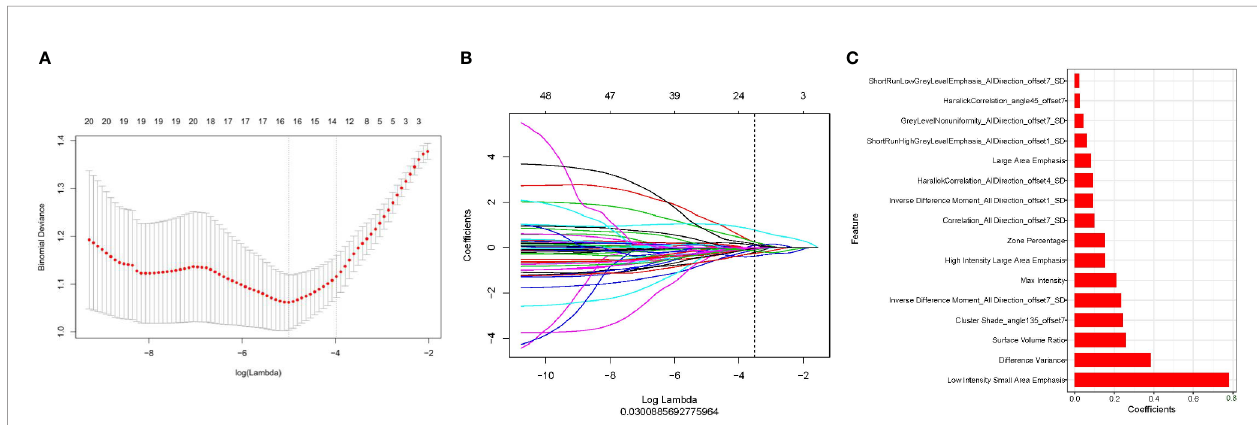
FIGURE 3 | Use of lasso logistic regression to select features. (A) Binomial deviation versus parameter l . Least absolute shrinkage and selection operator (LASSO) regression was used to screen the radiomic features, and cross-validation was used to select the optimal model parameter l . The vertical axis is the binomial deviation, and the horizontal axis is the log ( l ) value. l , which represents the smallest binomial deviation of the model, is the optimal value (vertical dashed line). (B) Graph of the variation of the imaging omics feature coef fi cient with l . The number above indicates the number of fi ltered features. (C) Screened 16 radiomics features and their weights.